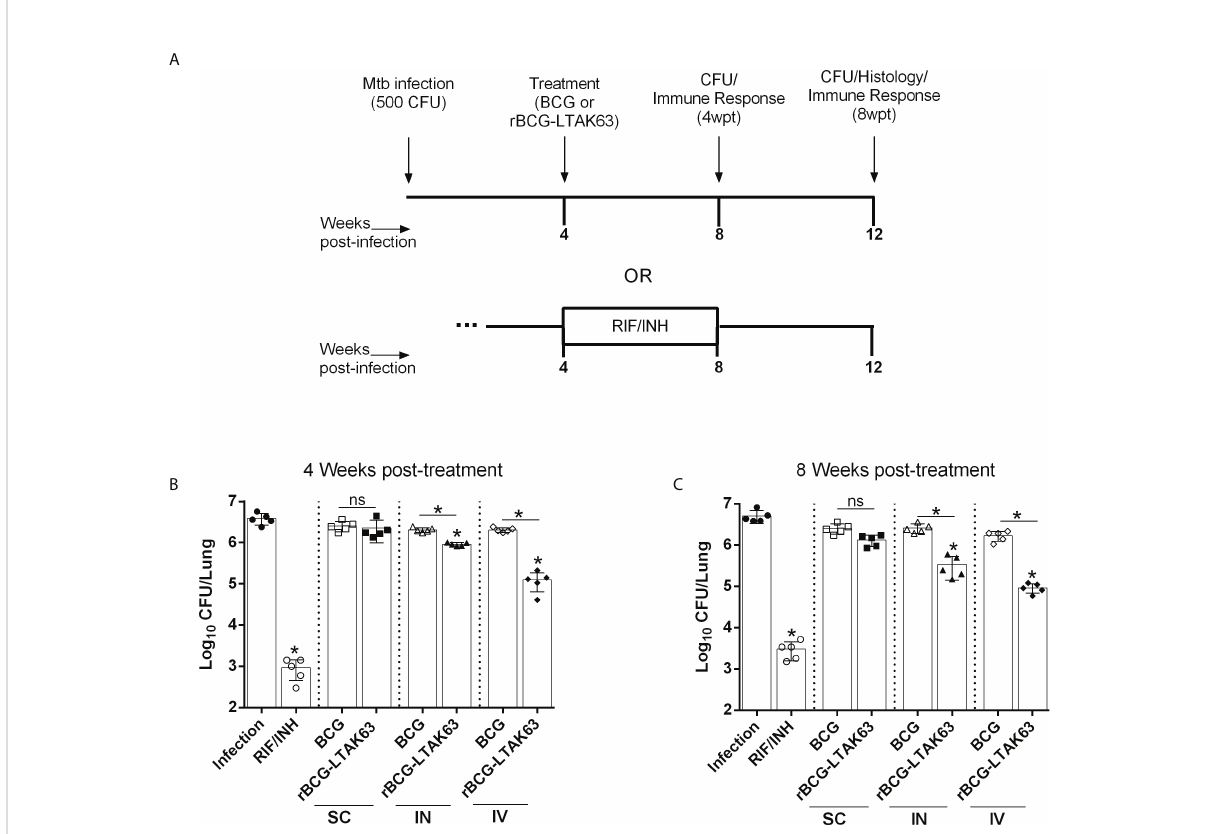
FIGURE 1 Therapeutic effect of rBCG-LTAK63 vaccine in Mtb-infected mice. (A) BALB/c mice were infected with Mtb (500 CFU/IN) and treated 4 weeks later with a single of BCG or rBCG-LTAK63 vaccine delivered by the subcutaneous (SC), intranasal (IN) or intravenous (IV) route. As a control, one group received rifampicin and isoniazid daily given by gavage for 4 weeks (RIF/INH). Four weeks (B) or eight weeks (C) post-treatment (4wpt or 8wpt), the lungs of these animals were collected and homogenized. Serial dilutions were plated onto 7H10 agar plates containing TCH (a BCG growth inhibitor) to assess Mtb CFU. Statistical differences were determined by one-way ANOVA with a Bonferroni test. * p values ≤ 0.05 were considered statistically signi fi cant and ns, not signi fi cant. Asterisks over the columns refer to the comparison with the infection group. Results are represented by the means ± SD of the CFU recovered in the cranial and median lung lobes from the groups of mice